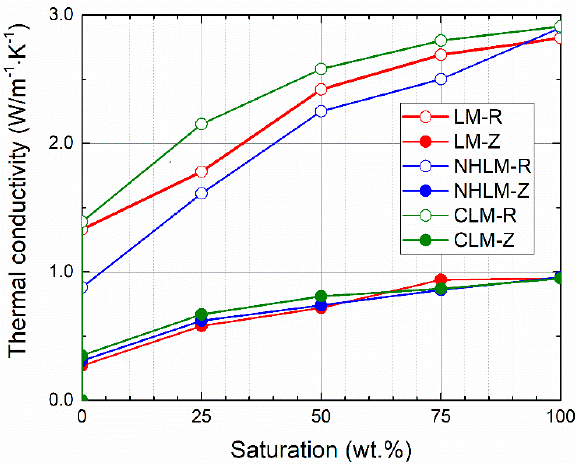
Figure 5. Moisture-dependent thermal conductivity—28-day samples.